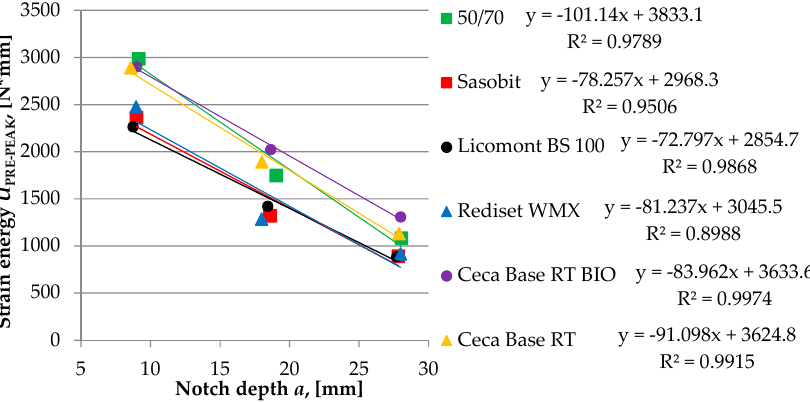
figure, 0.2, 0.4, 0.6, 0.8. Commented [C4R3]: If it is possible, please do not change charts dimensions.